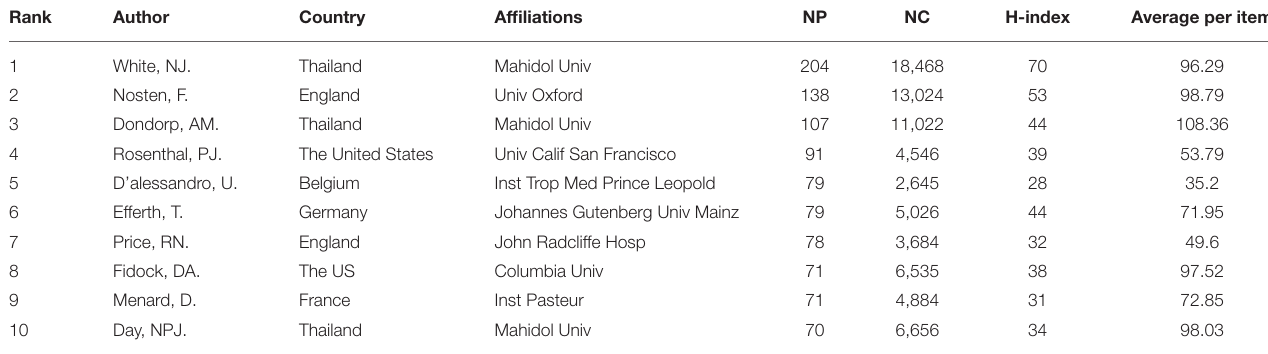
TABLE 3 | The top 10 authors with the most publications.